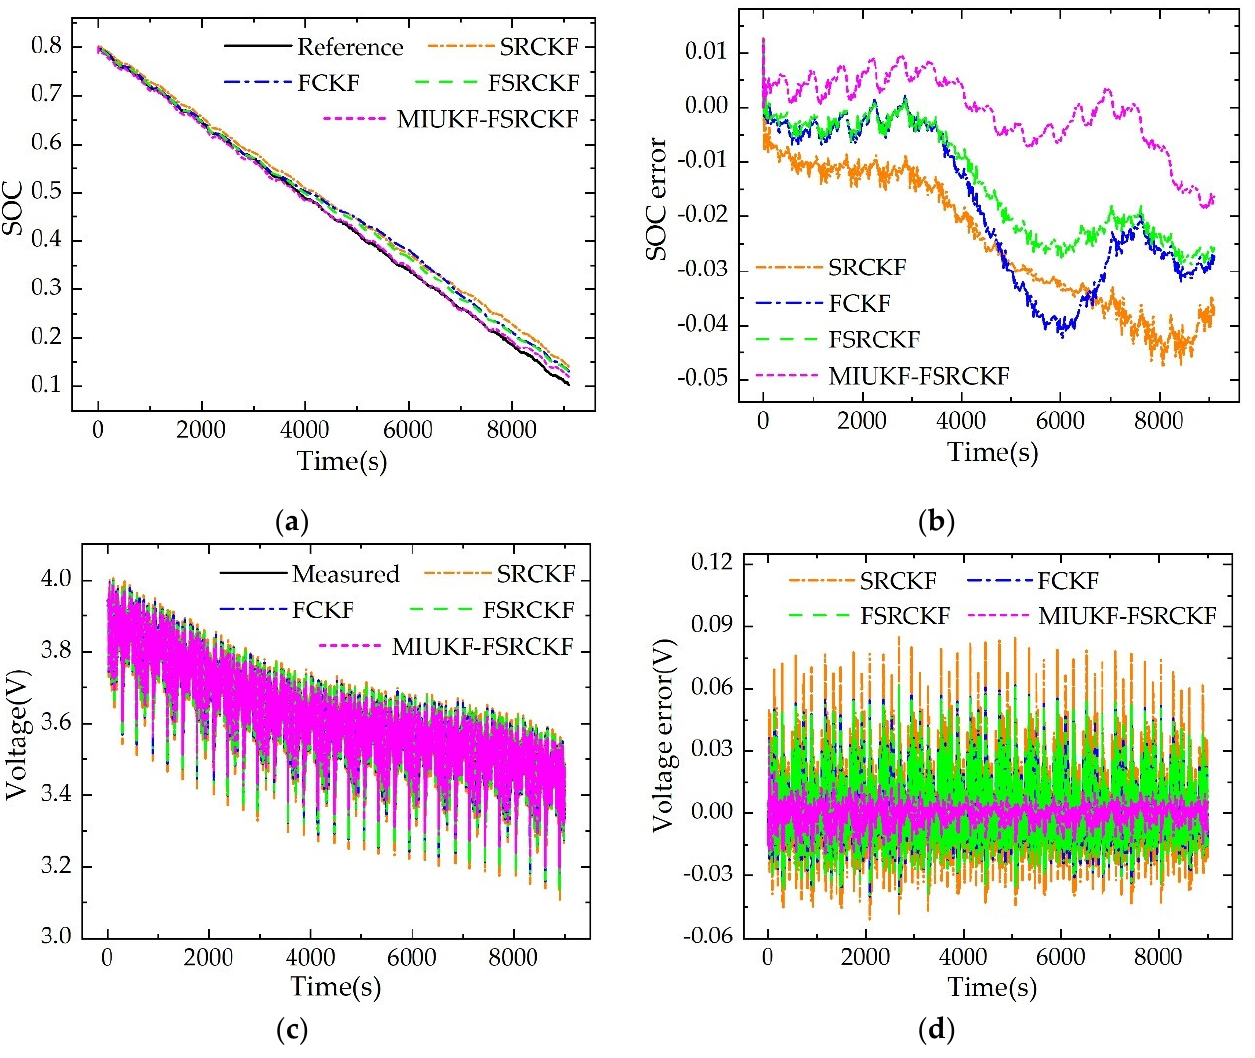
Figure 12. Comparison of the results of the four algorithms under the US06 test. The identified R 0 is increased by 20% as the initial value of R 0 : ( a ) SOC estimation result; ( b ) SOC error; ( c ) voltage estimation result; ( d ) voltage error. Table 8. SOC error and voltage error of each algorithm under the US06 test. (The identified R 0 by AGA is increased by 20% as the initial value of R 0 .)